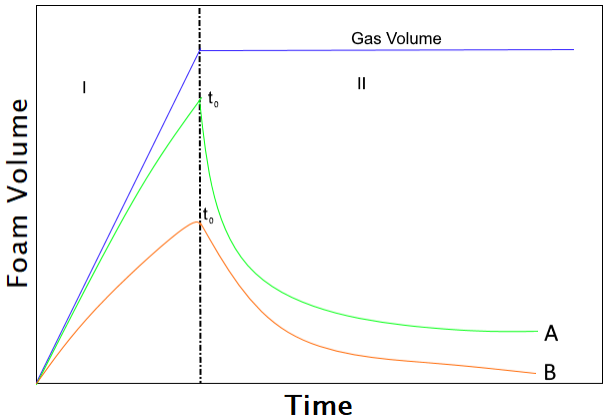
Figure 1. A schematic representation of sparging-test results. During the first period (I), the